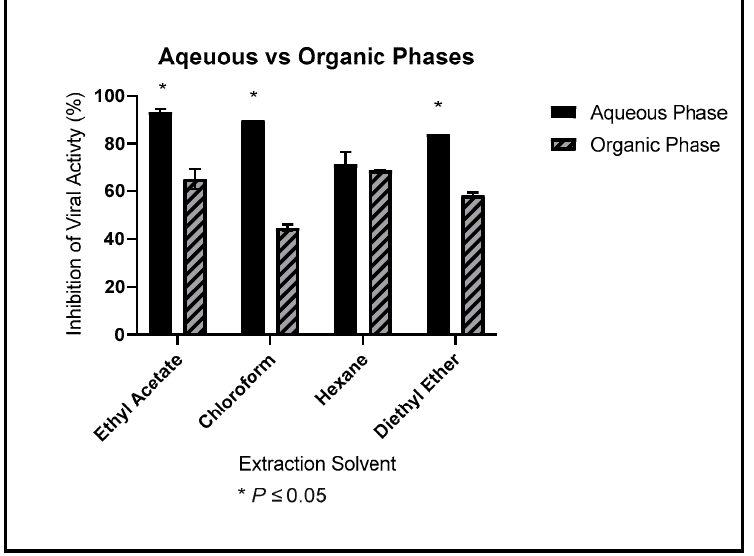
Figure 3. Dried M. balsamina leaves were extracted into ethyl acetate, chloroform, hexane, and diethyl ether. We separated the extracts into an aqueous and organic layer and used the layers to treat cells infected with 1 ng of HIV-1 NL4-3 . We show the average anti-HIV-1 inhibitory effects. The solid bar represents the aqueous layer, and the dashed bar represents the organic layer. The assay was done in triplicate. Table 4. Šídák’s Multiple Comparisons Test.